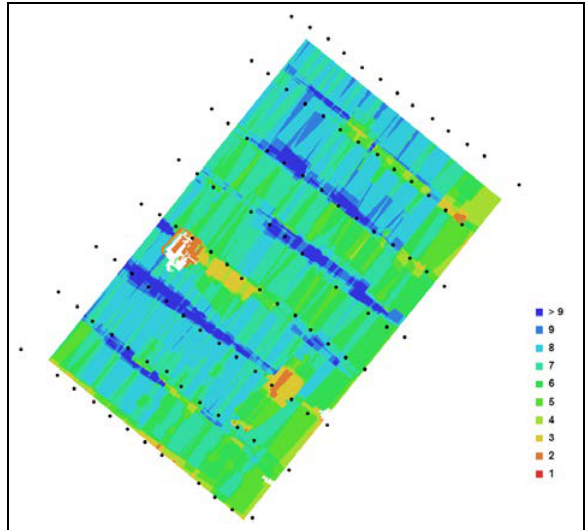
Figure 5 - Image overlap and camera locations of 70 m flight. 4. DSM